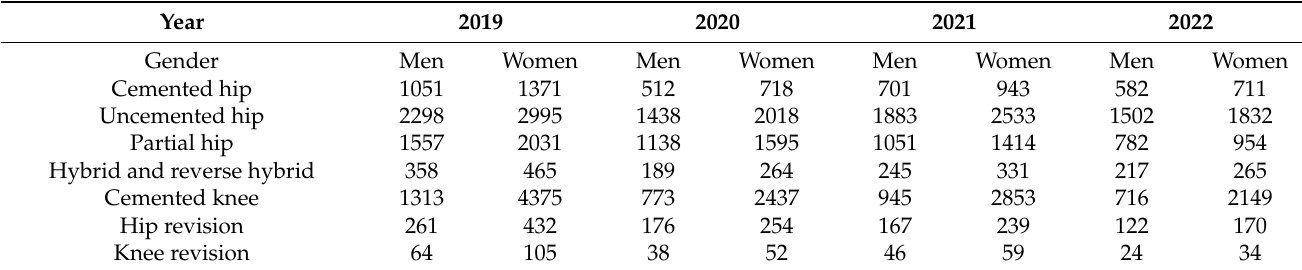
Table 1. Gender of patients who participated in the